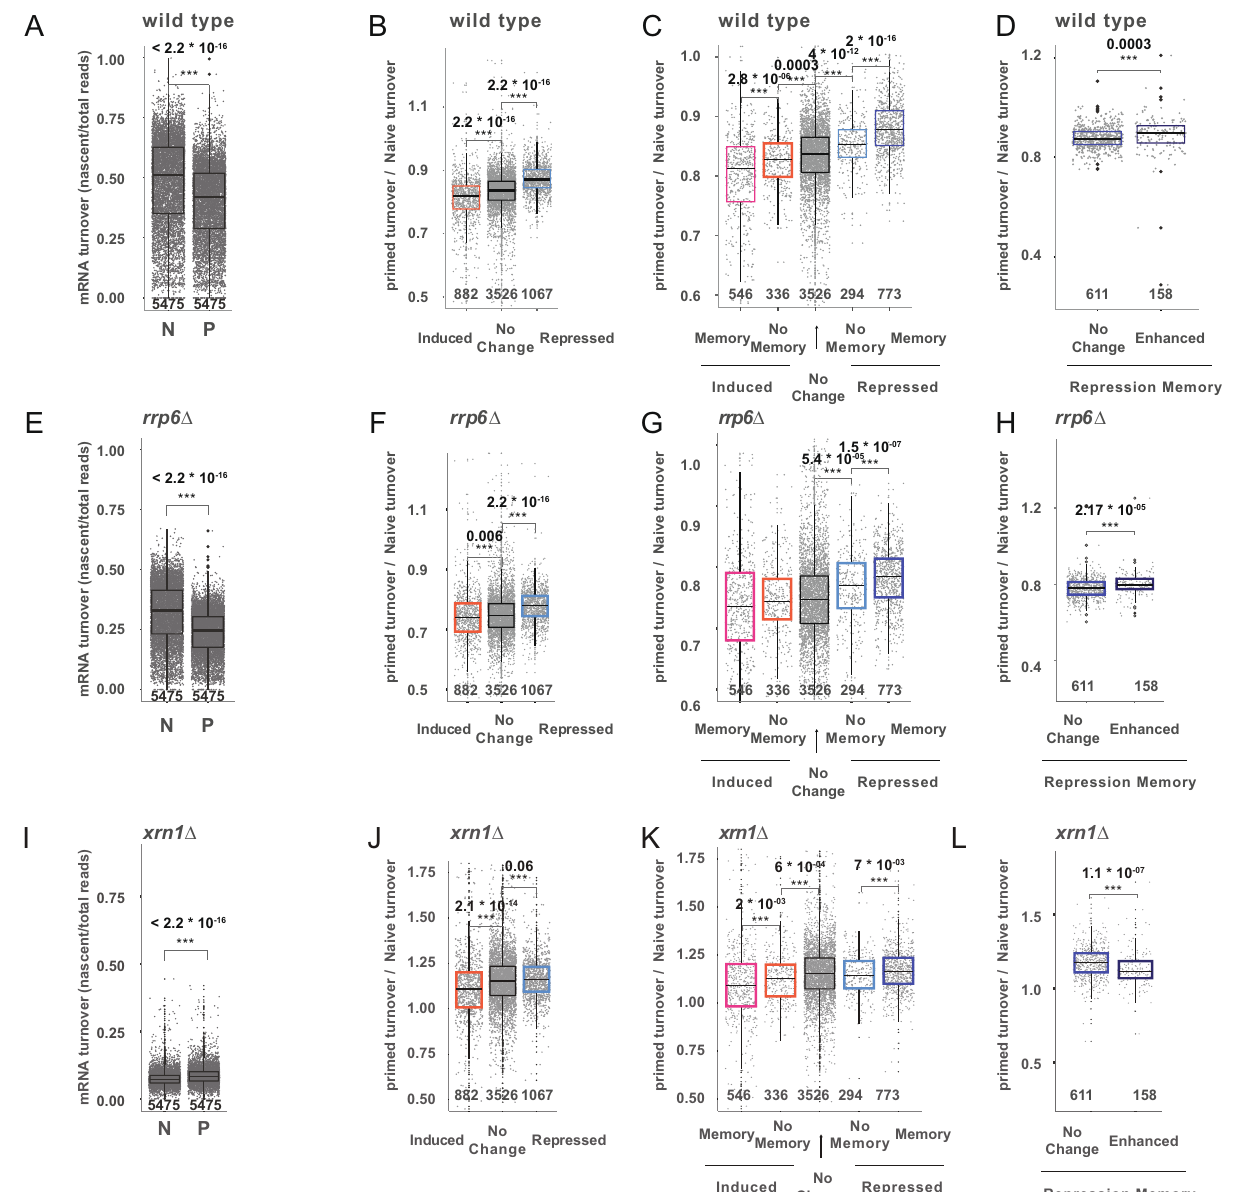
Fig. 5 | Differential mRNA turnover between naive and primed cells. A Relative mRNA turnover (comparing nascent vs total RNA) using SLAM-seq in naive (N, t 0 ) and primed (P, t 0 ’ ) conditions. High turnover indicates faster transcription/decay and thus lower mRNA stability. Gene-speci fi c turnover was computed by compar- ingfor eachgene thereadscontaining T>C conversion tothe totalmapped reads. Onlyreadscontainingatleast2T>Cconversionsareconsiderednewlysynthesized reads. Only genes with at least 20 total reads were considered for RNA turnover analysis. B Change in mRNA turnover between primed and naive conditions for inducedandrepressedgenesinresponsetogalactose.Numberofanalyzedgenesis